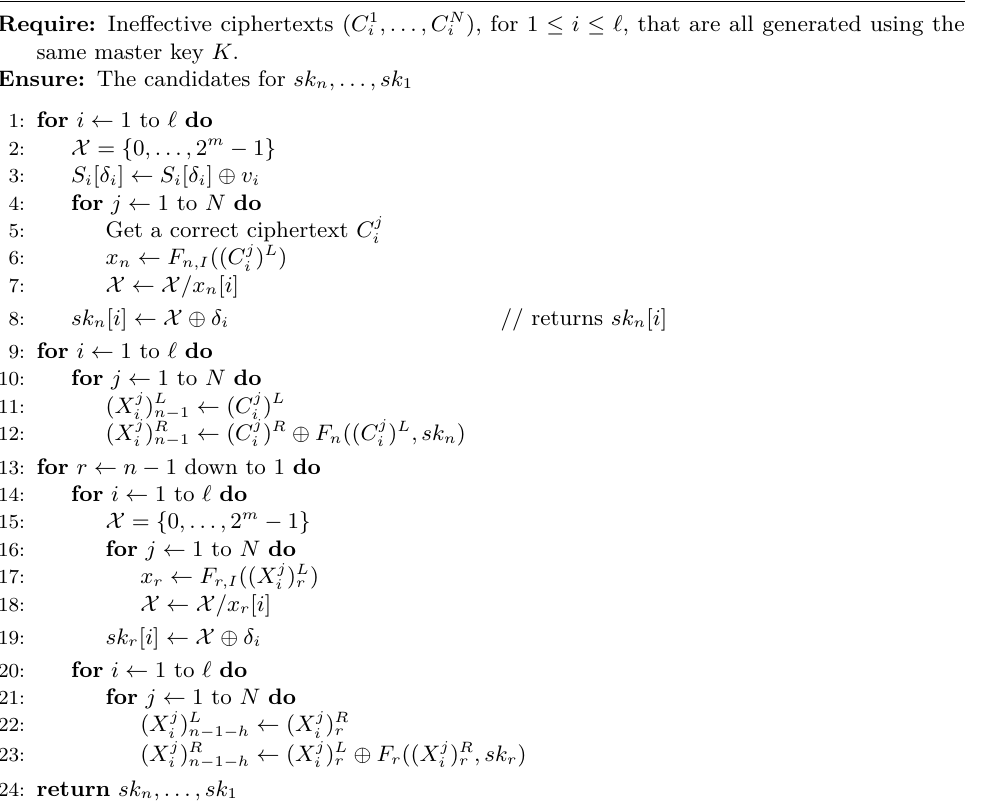
is known for 1 ≤ i ≤ ‘ , where C j i